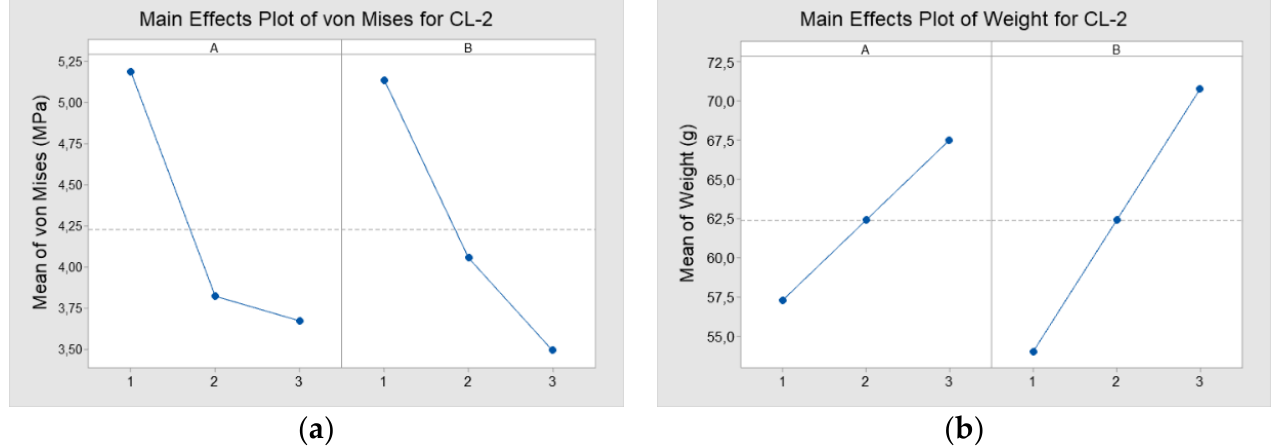
Figure 12. Study of the effect of the thickness of the first and second regions for the CL-2 structure. A and B refer, respectively, to the thickness of the first and second regions. ( a ) von Mises stress. ( b ) structure weight.